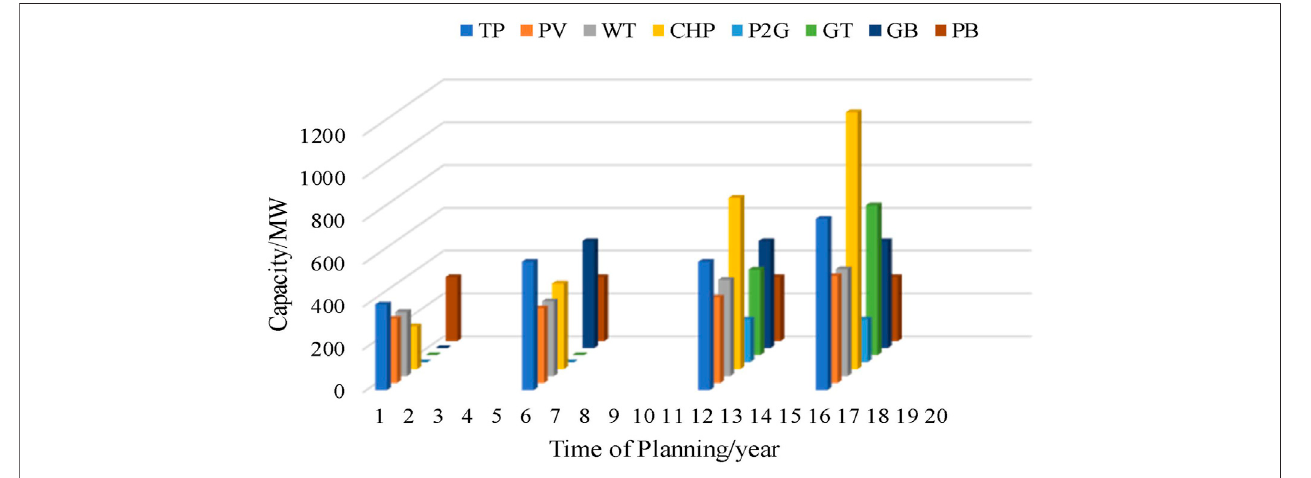
FIGURE 8 | Planning and configuration results of case 3.